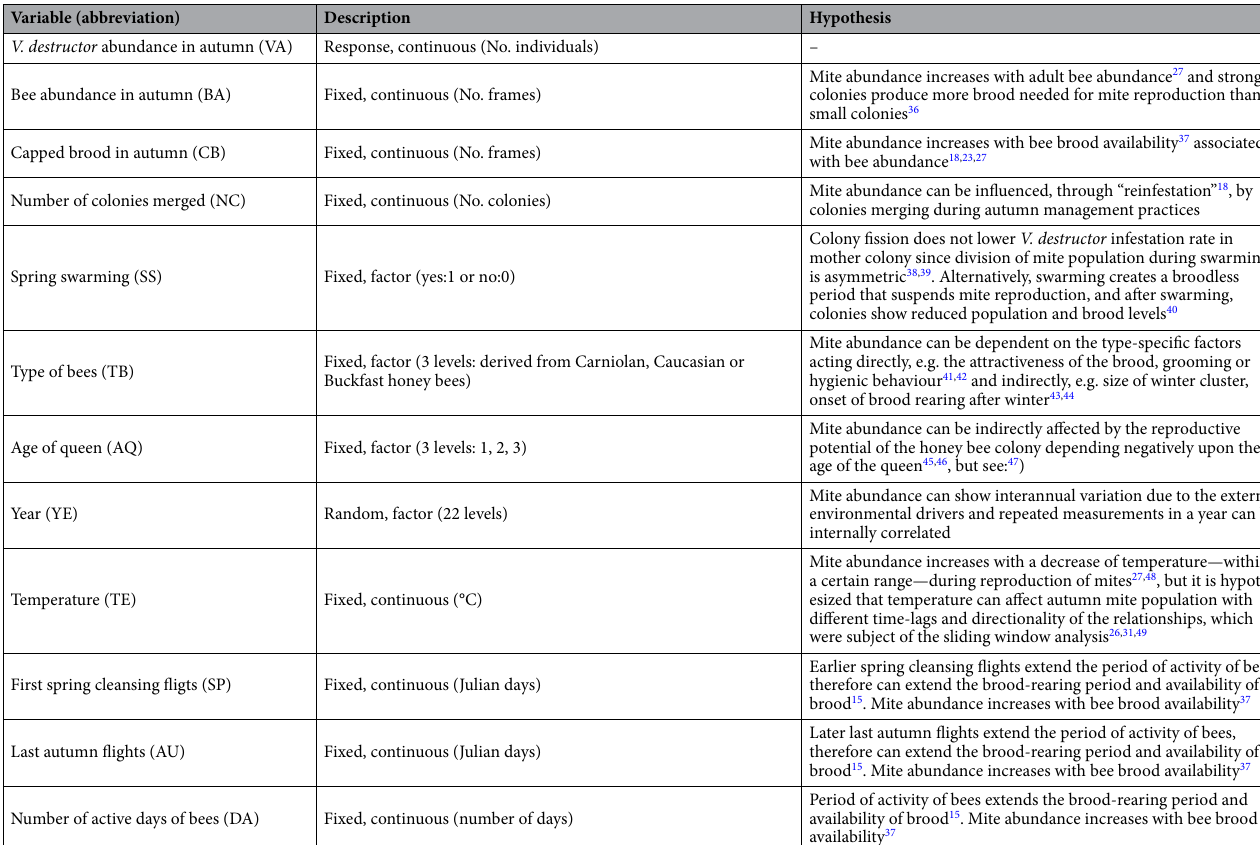
Table 1. List of variables used in the modelling of the autumn V. destructor abundance in the A. mellifera colony. The type of the variable, detailed description and proposed hypotheses are